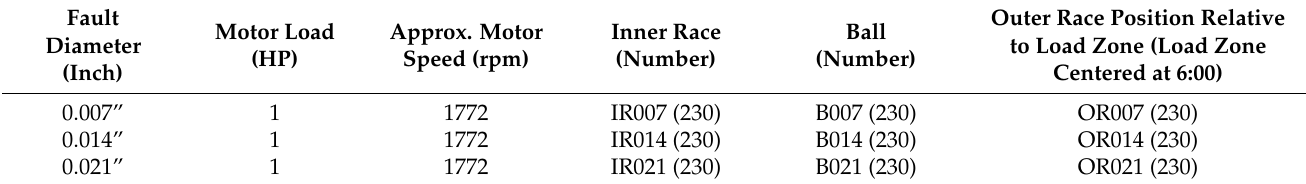
Table 1. Electric motor fault condition and load and speed record on the drive